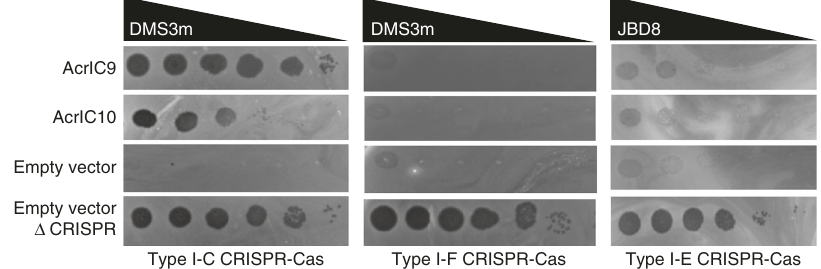
Fig. 7 Identi fi cation of anti-CRISPR proteins AcrIC9 and AcrIC10. Phage DMS3m or JBD8 spot titration from left to right (tenfold serial dilutions) on lawns of P. aeruginosa strains expressing the indicated CRISPR-Cas system ( X -axis, type I-C, I-F, or I-E), with a crRNA targeting the indicated phage and the indicated Acr or empty vector ( Y -axis). During screening of all candidate Acr proteins against all three systems, each combination was screened once. Upon detecting inhibition, positive results were visually con fi rmed in